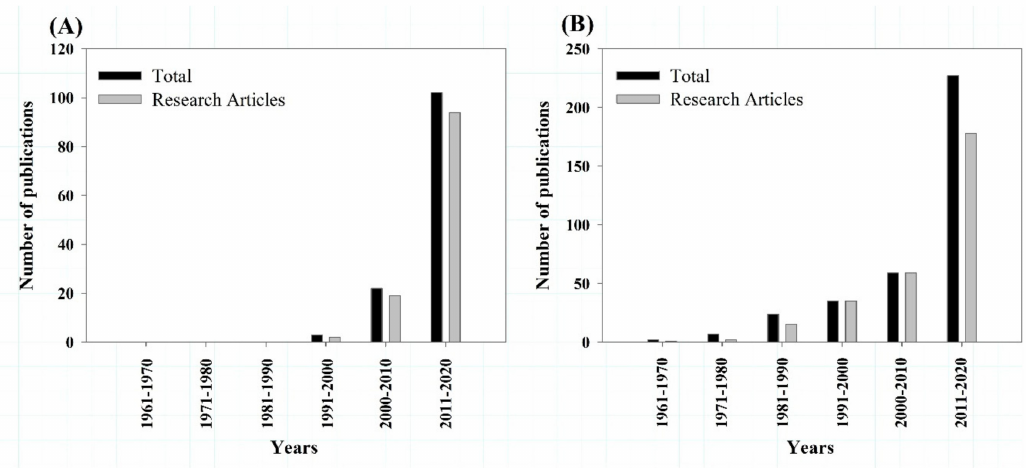
Figure 1. Remote sensing of phycocyanin publication numbers from the search in each database. ( A ) From Web of Science, ( B ) From Science